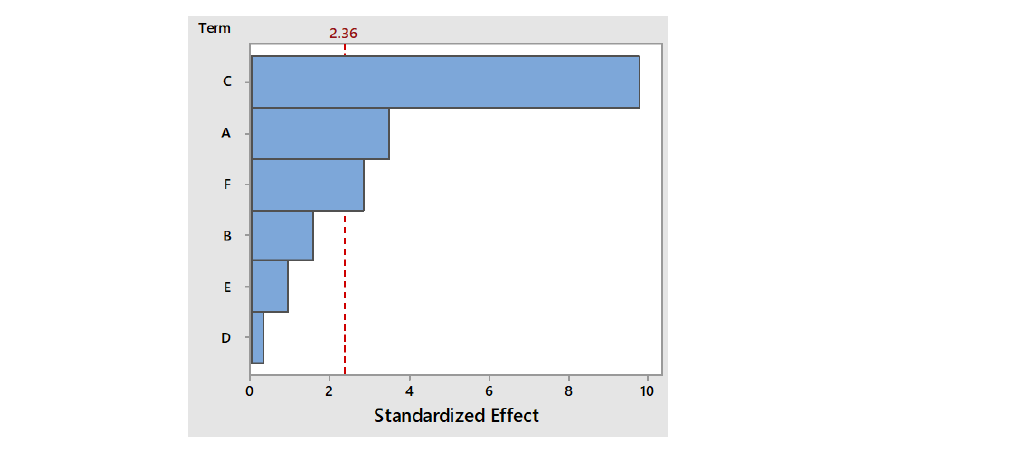
Figure 1. The Pareto chart of the effect of the studied independent variables upon the acidity of the fermented products.